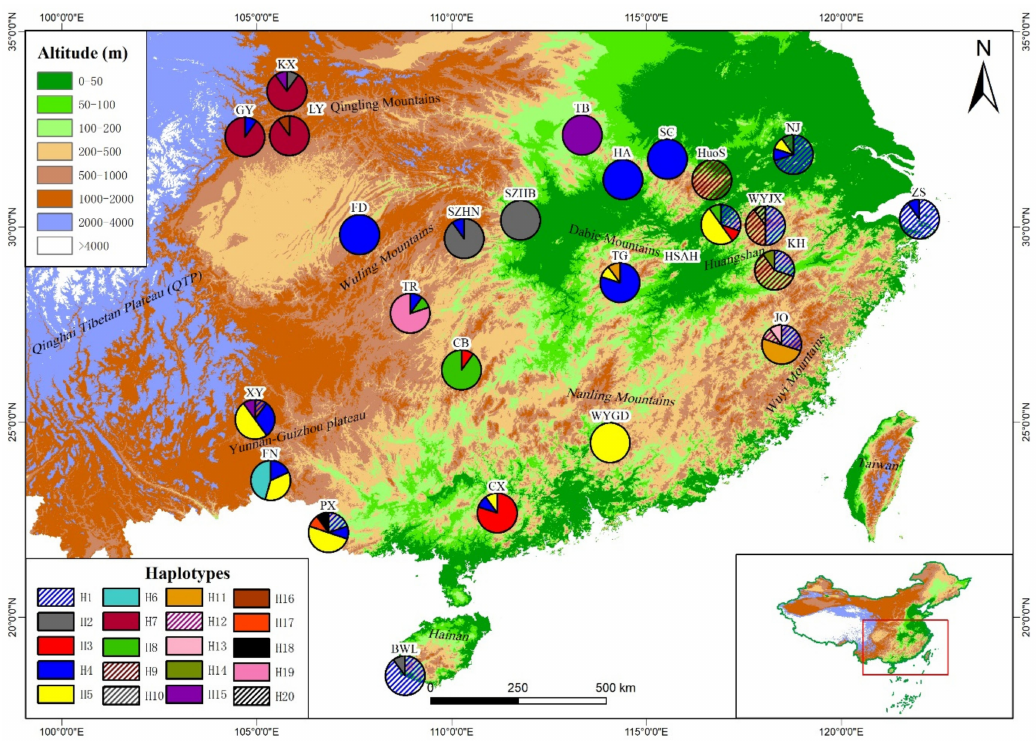
Figure 1. Geographic distribution of haplotypes (H1–H20) detected in Liquidambar formosana.